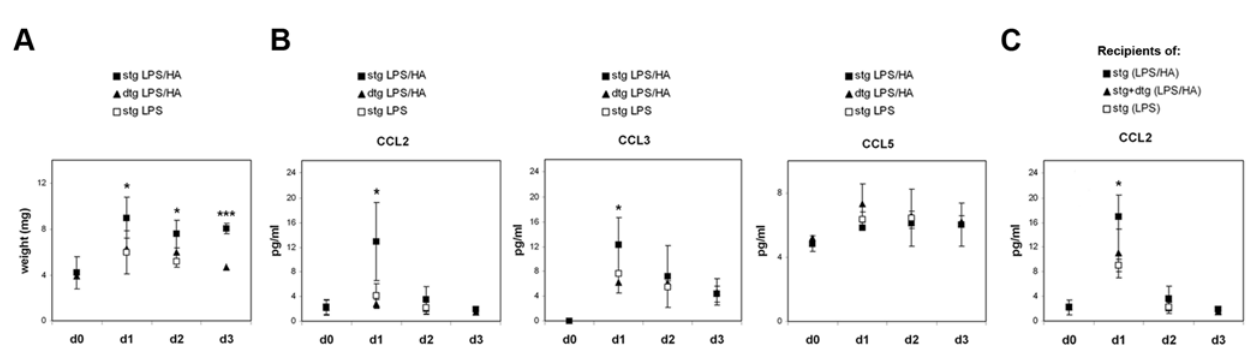
Figure3.Effectsof Tregsonchemokineproductionduringanimmuneresponse. Stgand dtgmicewereinjected inthe footpadwithHA peptide (1 m g) together with LPS(0.5–1 m g). Controlmice received LPS aloneor nothing. Mice were sacrificed at differenttimes after injection,as indicated. (A)dLNs were weighed and (B) CCL2, CCL3 and CCL5 chemokine content after homegenization was determined by ELISA. Shown are the pooled data from two independent experiments, with two to three mice per group in each experiment. (C) BALB/c mice were adoptively transferred with CFSE-labelled 6.5 + cells obtained from stg mice without or with equal numbers of 6.5 + cells isolated from dtg mice. The mice were immunized as described above. dLN were harvested and CCL2 amounts were determined by ELISA. Data from two pooled out of three independent experiments performed are